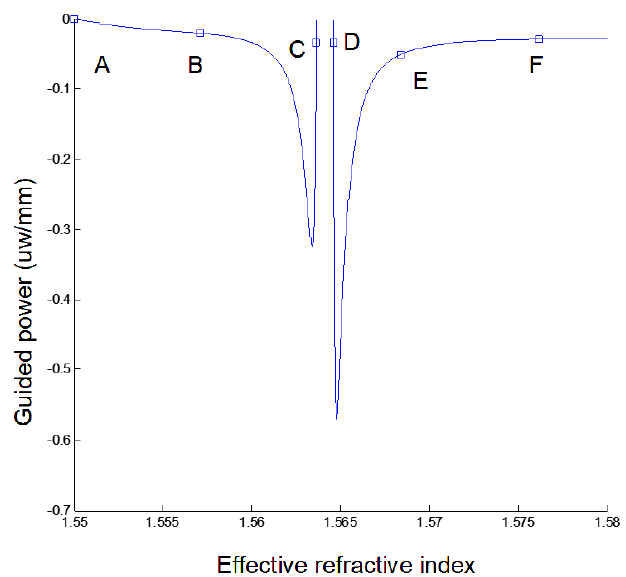
Figure 8. Dispersion curve of five-layer metamaterial waveguide with nonlinear cladding and substrate at d f = 5 μ m and d i = 6 μ m.